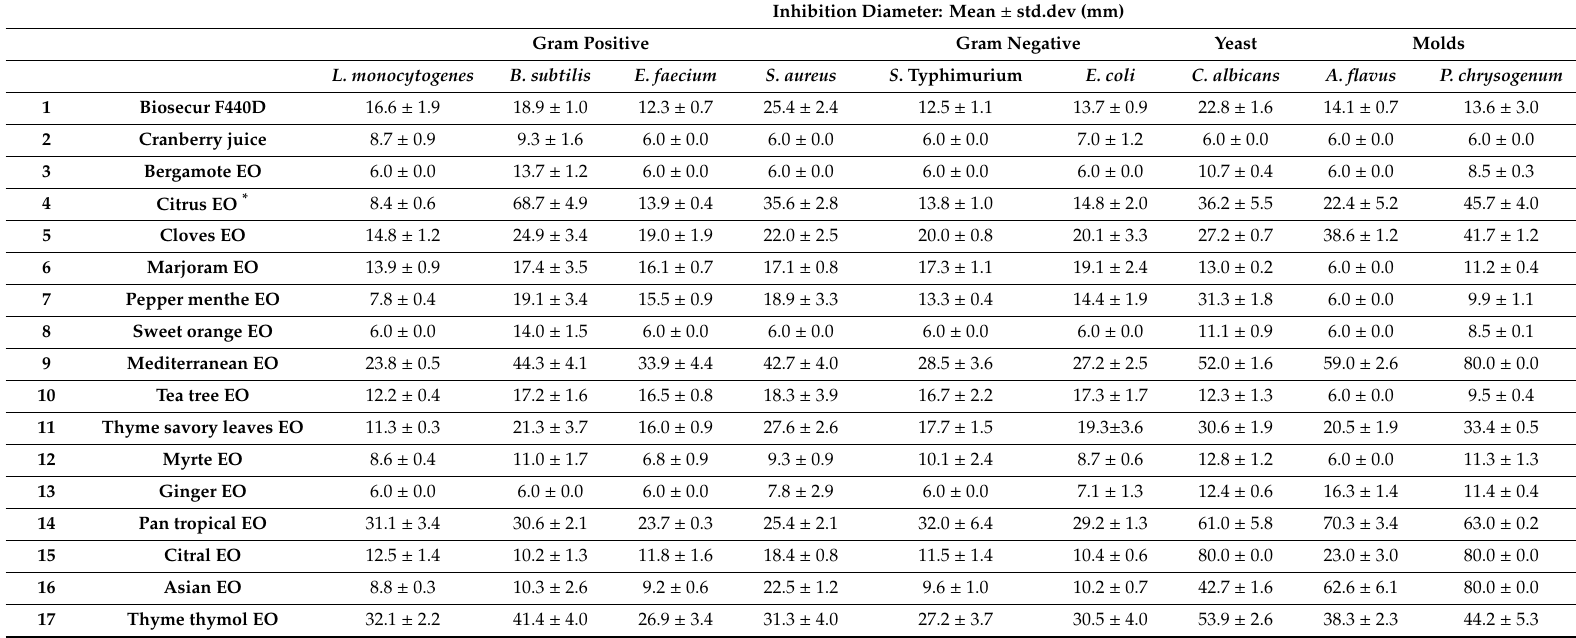
Table 2. Inhibitory diameter of antimicrobials extracts against tested microorganisms ( n =